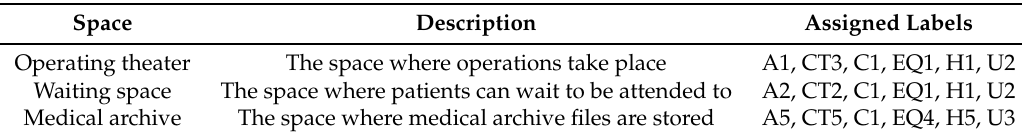
Table 2. An example of a hospital’s space